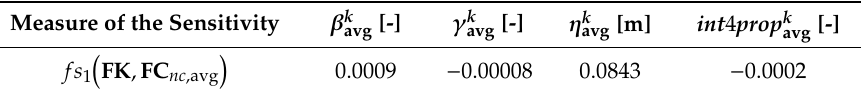
Table 6. Measure of the